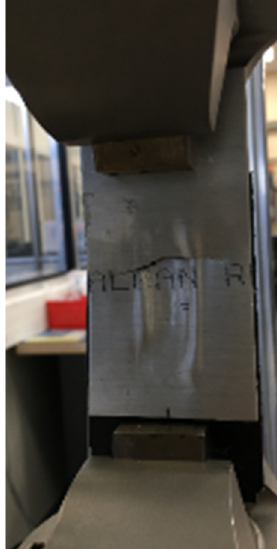
Figure 13. 5182 flyer metal tearing during fatigue test for the joint with FRPC using the steel DC04 metallic insert.